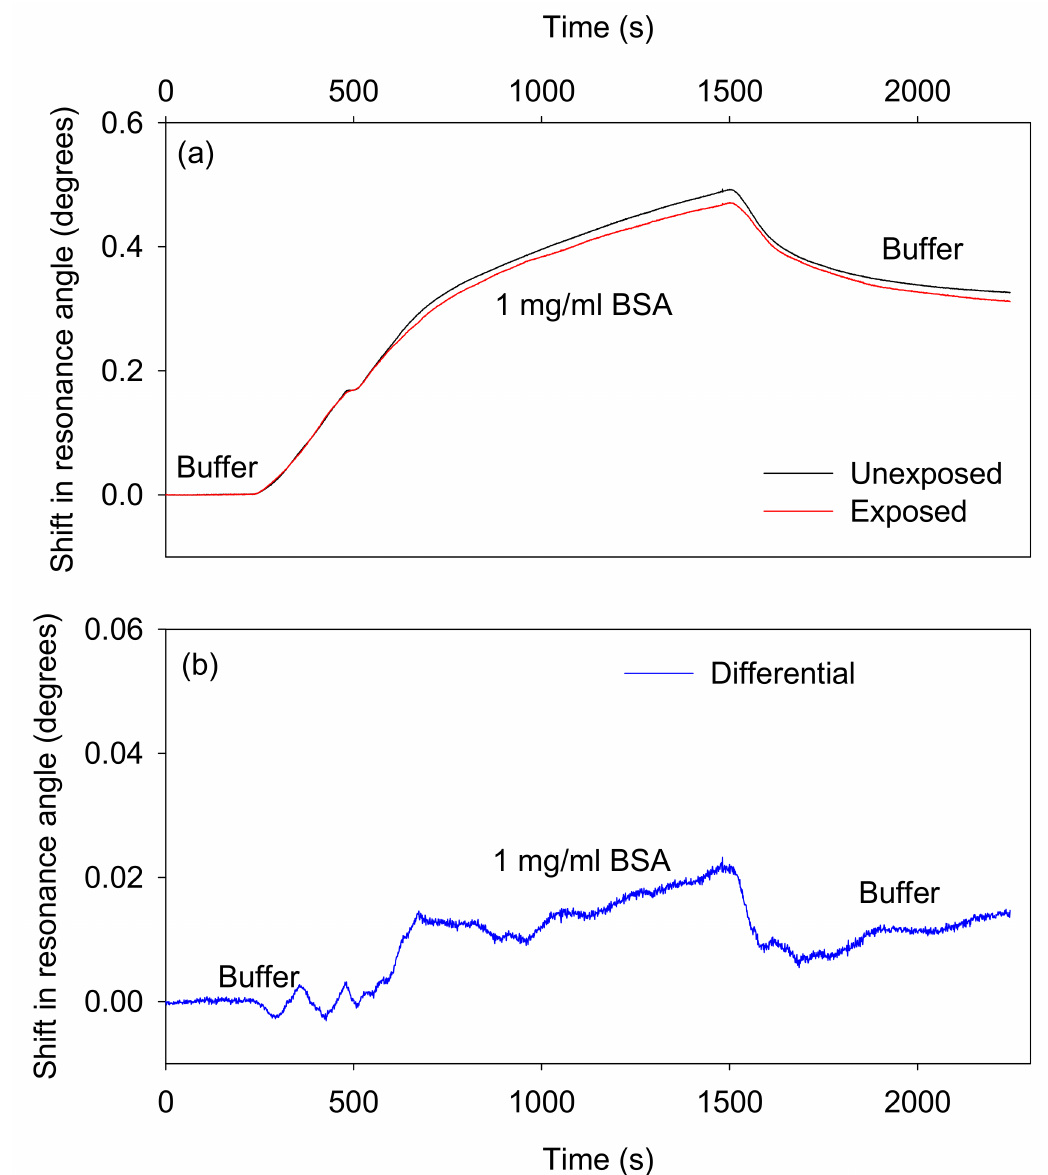
Figure 8. ( a ) Absolute and ( b ) di ff erential shifts in the resonance angles of the self-referenced di ff raction-based LW to non-specific adsorption of 1 mg / mL BSA prepared in 100 mM HEPES bu ff er, pH